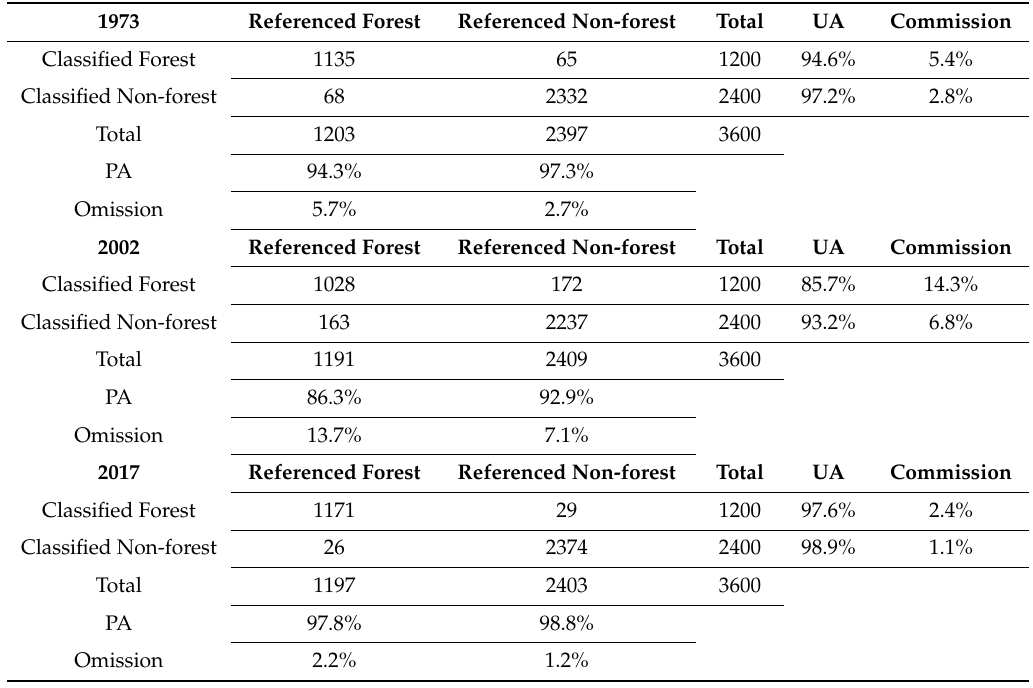
Table 3. Confusion matrices summarizing out of bag error estimation rates for forest and non-forest land-cover